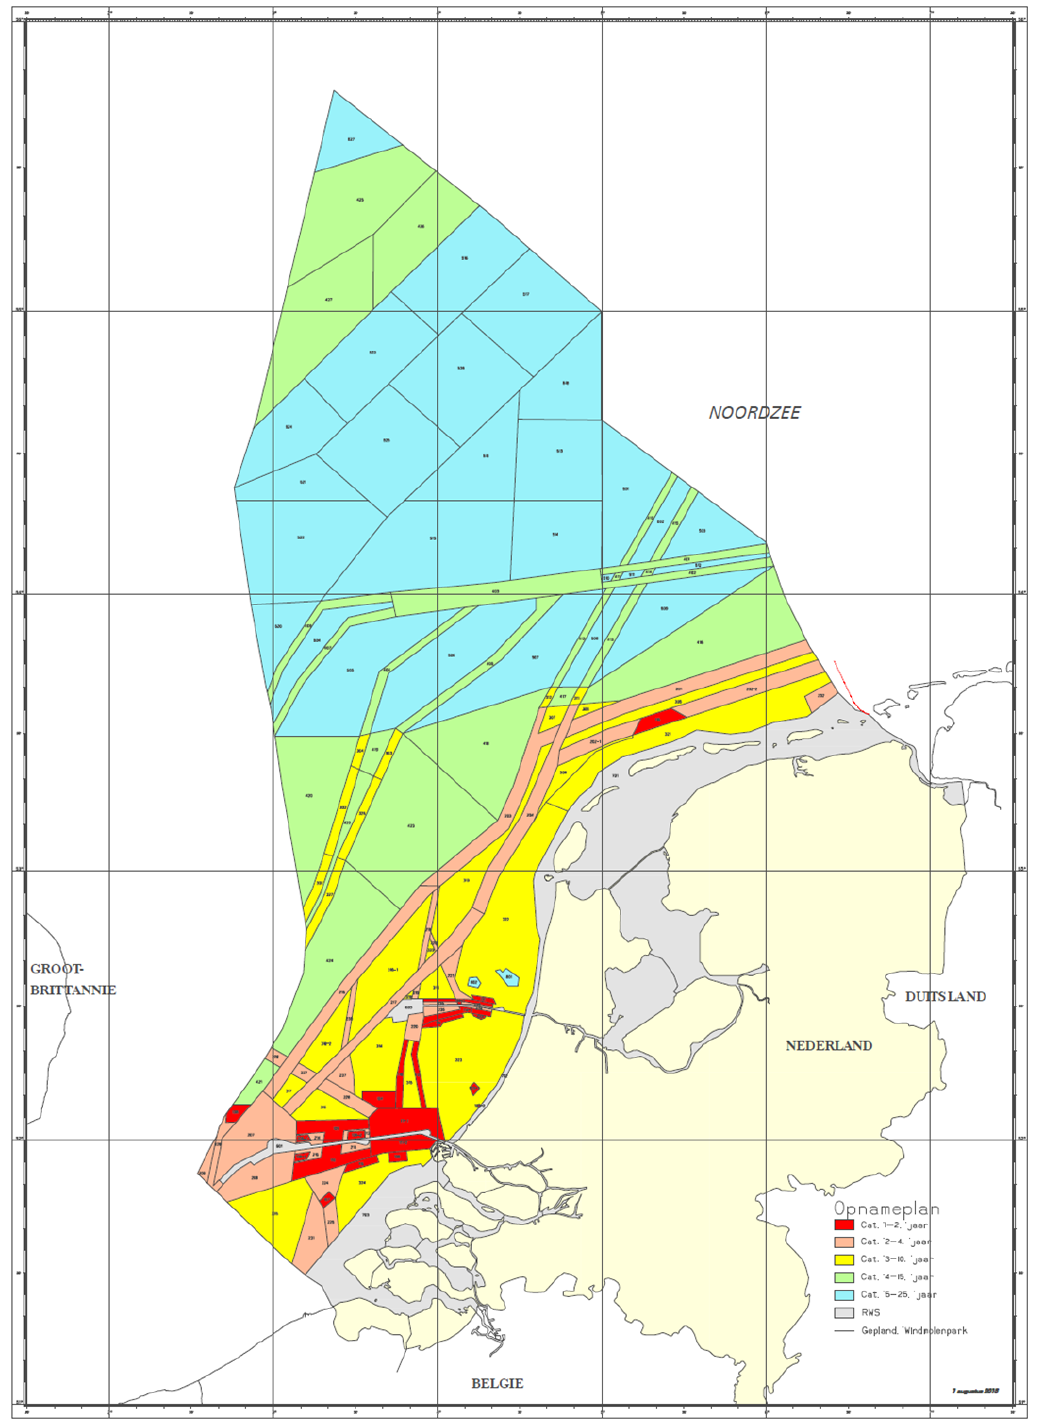
Figure 1. Map of Netherlands Continental Shelf resurvey frequencies, courtesy of NLHS 2017. The Categories are listed from Cat 1 (red) to Cat 5 (cyan) with respective resurvey frequencies once every 2 years, 4 years, 10 years, 15 years and 25 years. The nearshore grey areas are the responsibility of